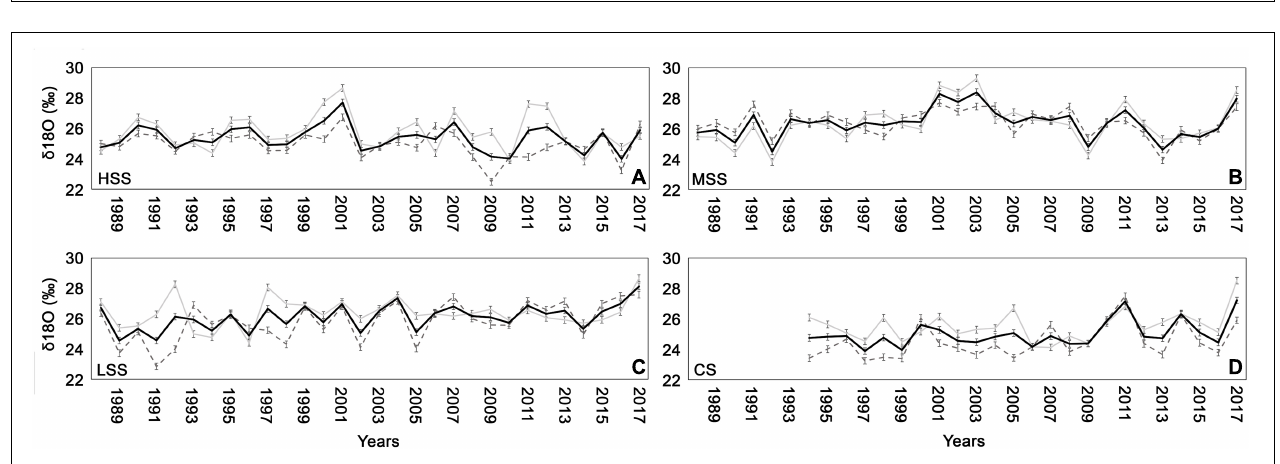
Frontiers in Plant Science |